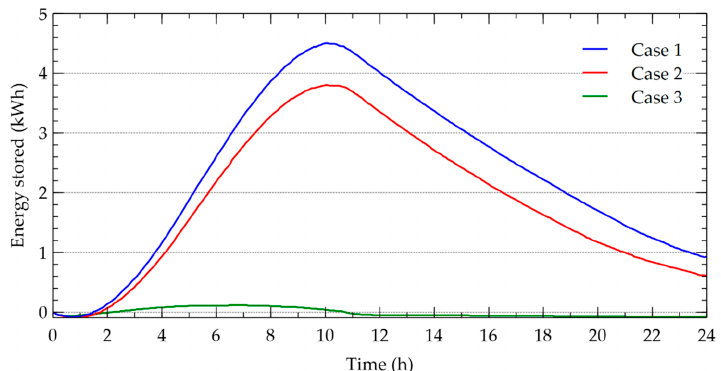
Figure 16. Estimated energy stored by the components.